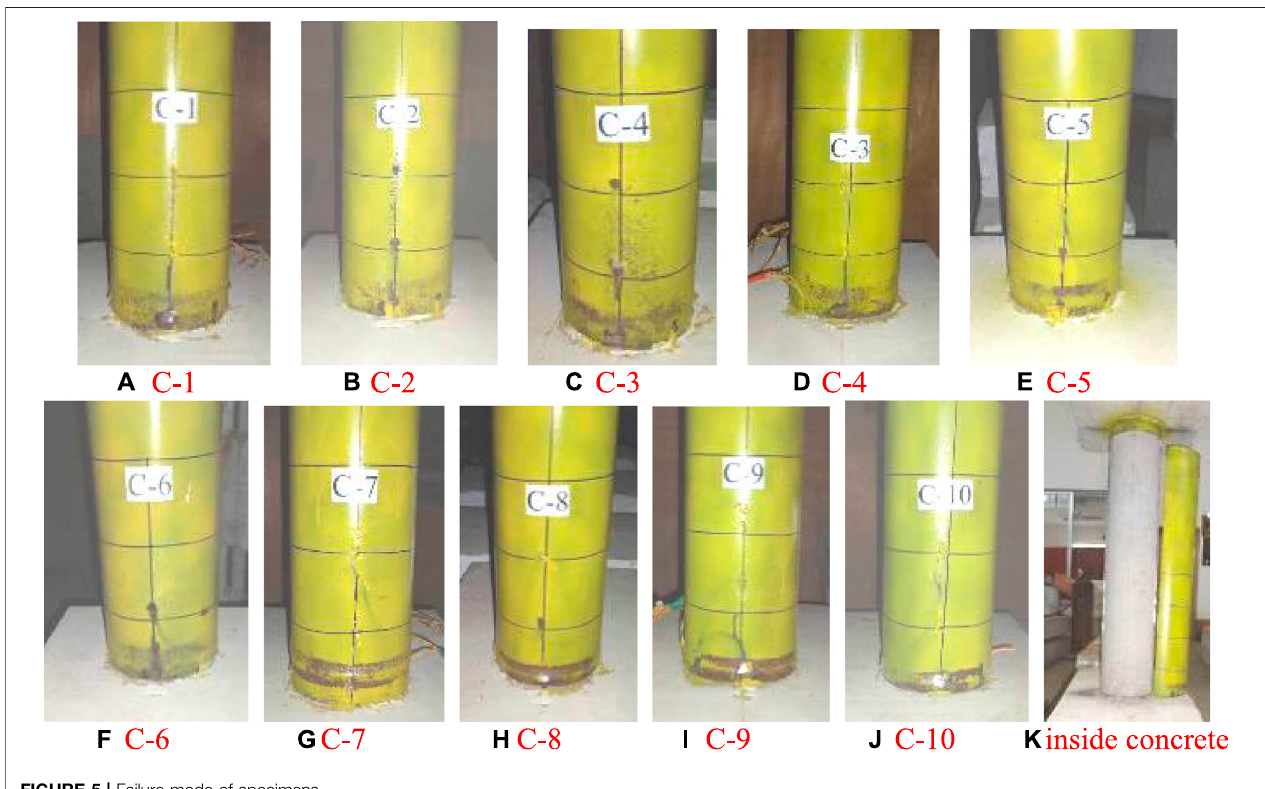
FIGURE 5 | Failure mode of